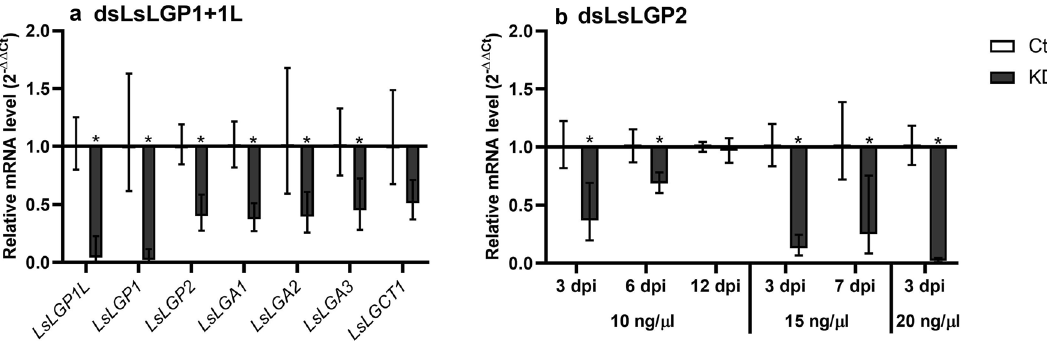
Figure 4. Expression of L. salmonis labial gland protein ( LsLGP ) genes after dsRNA treatment. ( a ) Expression of LsLGP genes in dsLsLGP1/1L treated copepodids 3 days post infestation related to the LsEF1α and LsADT3 reference genes (N = 8). In addition to KD of the targeted genes, KD of LsLGP2 and four additional, yet unpublished, genes confirmed to be expressed in the lice labial gland called L. salmonis labial gland astacin (LsLGA) 2–4 and L. salmonis labial gland chymotrypsin 1 (LsLGCT1), were analyzed. ( b ) Expression of LsLGP2 in dsLGP2 treated copepodids 3 days post infestation related to the LsEF1α and LsADT3 reference genes (N = 8). Statistical significance was teste with Student’s t-test (p ≥ 0.05) between control and dsRNA treated group and is denoted with an